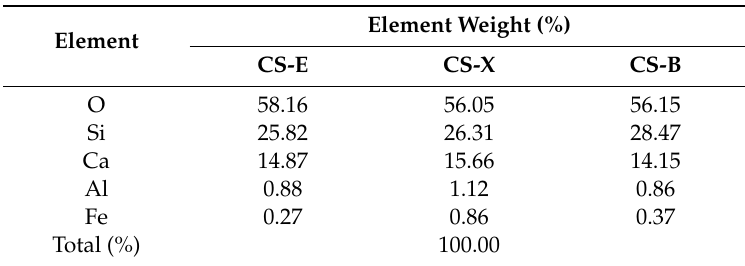
Table 2. The proportions of the weights of main elements in the tested specimens.